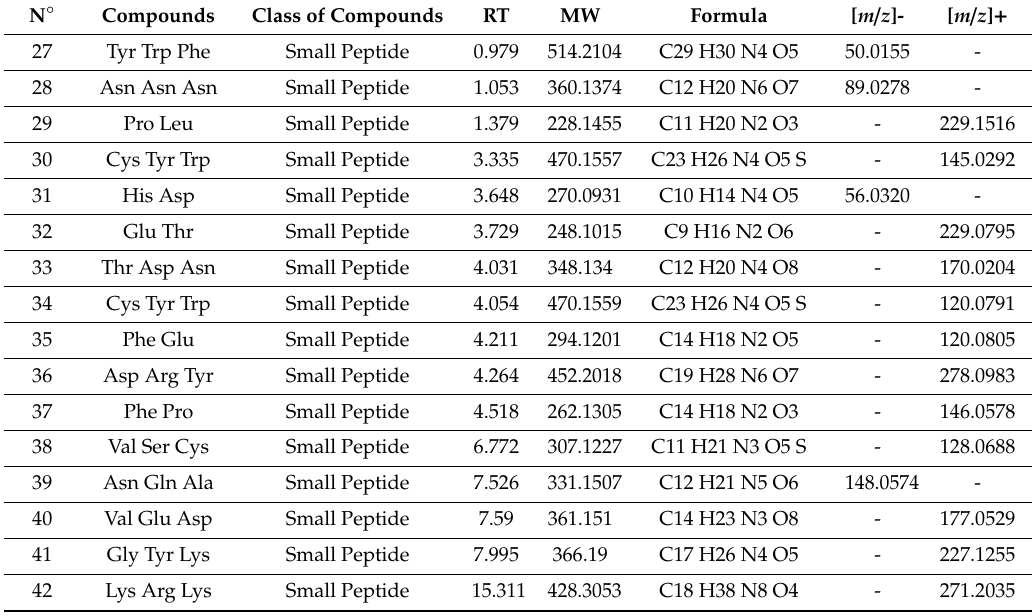
Table2. Peptide-likeproteinsidentifiedbytheHR-LCMStechniquein A.subhirsutum